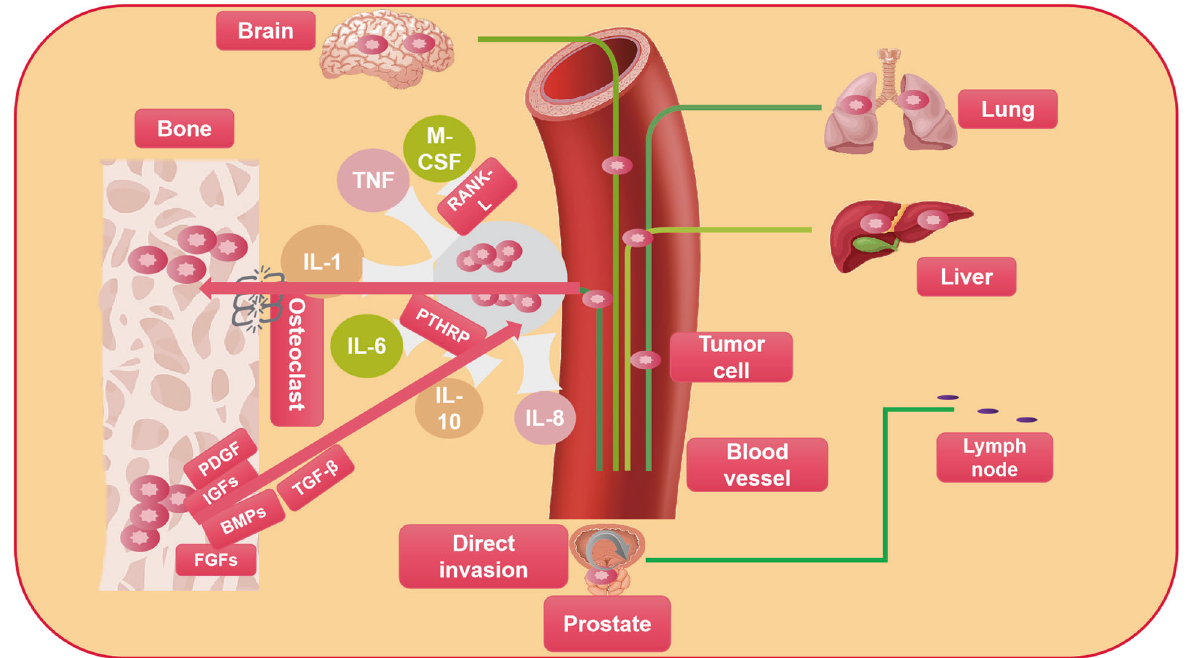
Fig. 1 The basic metastatic sites and pathways of PC and the vicious circle of osteolytic metastasis. Prostate cancer mainly metastases to the bone, but some tumor cells also spread through the blood to the viscera, such as the lung, liver, and brain. In addition, PC can also develop direct spread and lymph node metastasis. Parathyroid hormone-related peptides secreted by tumor cells are the major stimulators of osteoclast formation. Additionally, cancer cells also generate other factors, the formation of which promote osteoclasts, including prostaglandin E2 (PGE2), interleukin, macrophage colony-stimulating factor (M-CSF), and tumor necrosis factor. These factors increase the expression of nuclear factor-KB ligand receptor activators (RANKL), which acts on preosteoclast to induce bone resorption and osteoclast formation directly. Bone resorption releases factors including platelet-derived growth factor (PDGF), fi broblast growth factors (FGFs), insulin- like growth factors (IGFs), bone morphogenetic proteins (BMPs), and transforming growth factor b (TGF-b), which can enhance the parathyroid hormone – related peptide production through cancer and growth factors, thereby promoting tumor growth. Tumor growth and bone destruction are further increased because of the symbiotic connection between tumor growth and bone